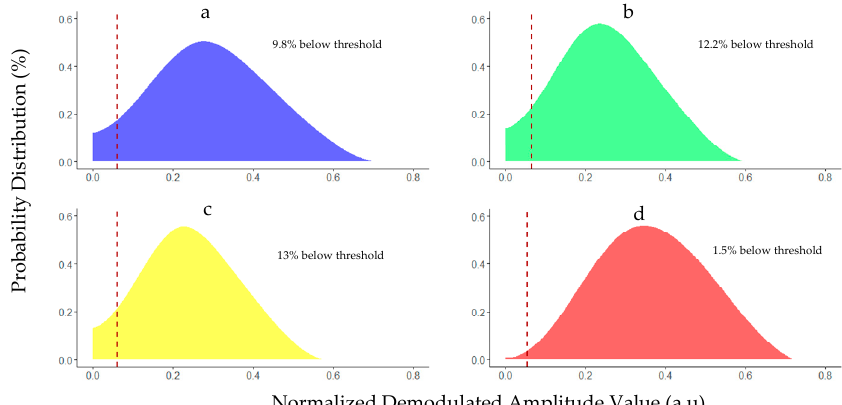
Figure 3. Probability distributions (whole recorded data). ( a ) 40 MHz, ( b ) 80 MHz, ( c ) 150 MHz, ( d ) Maximum values for each chosen section. The vertical red line shows the threshold (Gaussian curve fitting method applied on all plots).